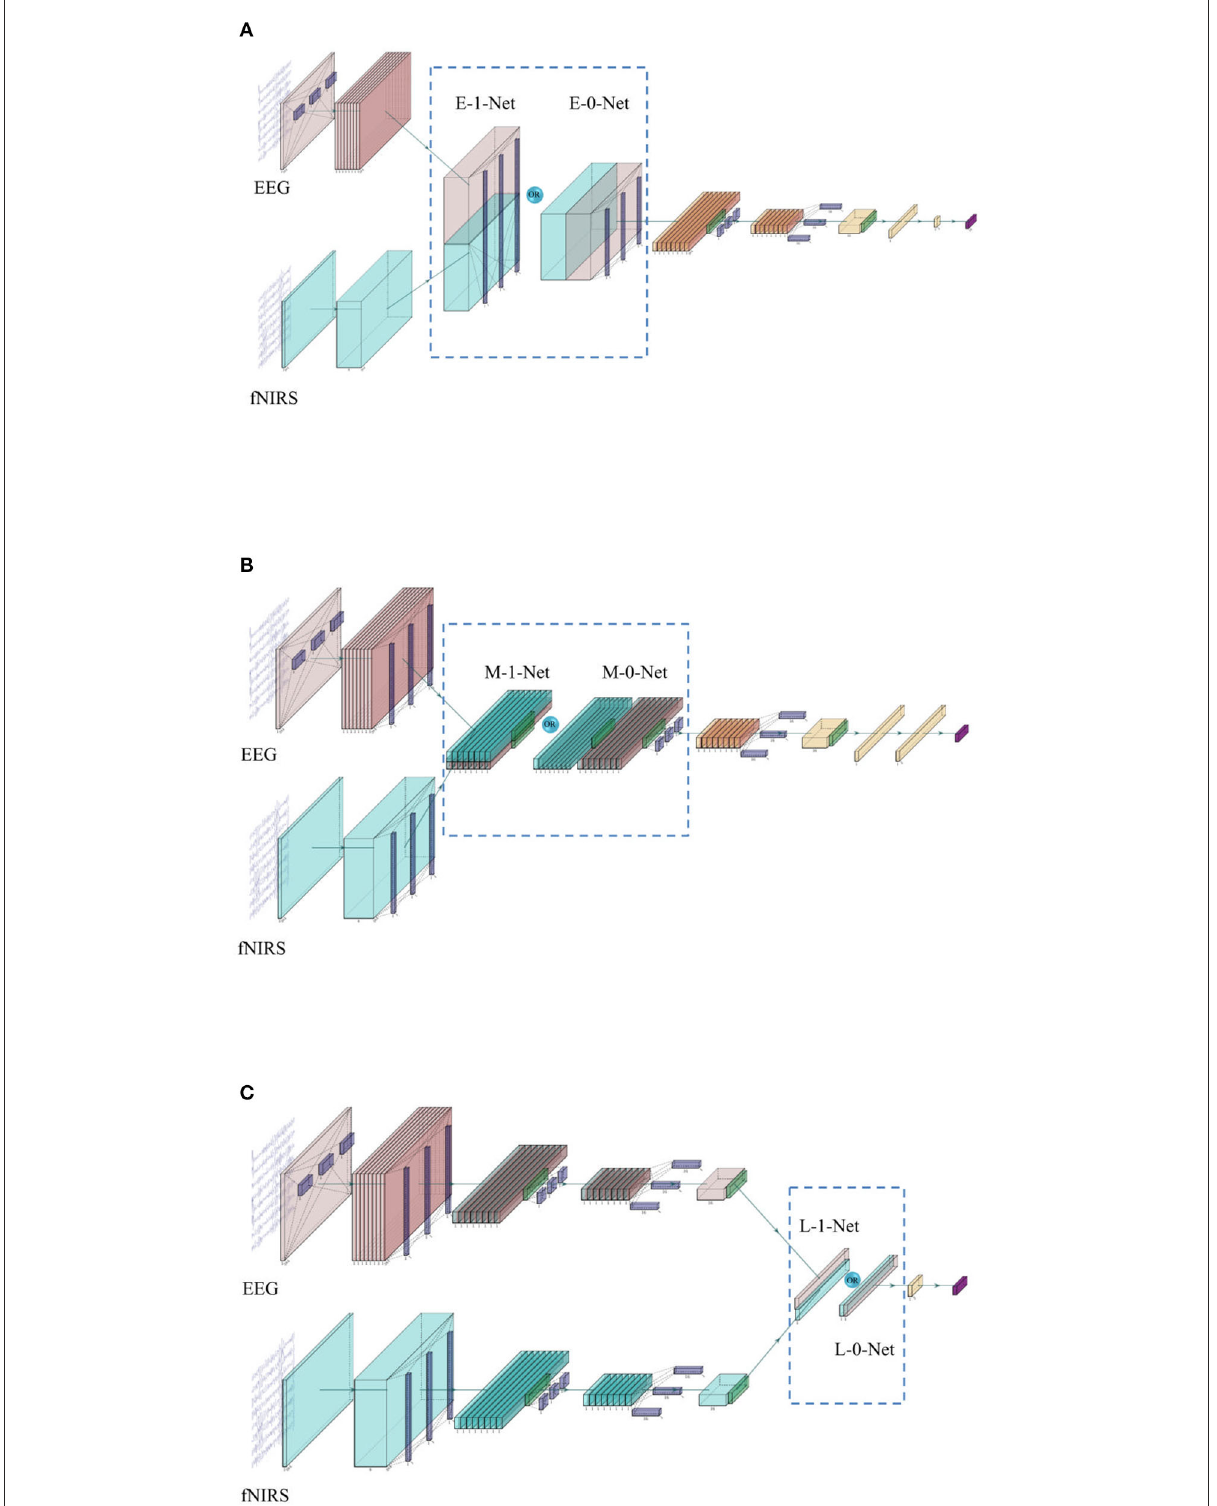
FIGURE2 (A) The network architecture of early stage fusion, which is referred to as E-0-Net and E-1-Net in the following contents, depends on whether the concatenation was performed on the 1st or 2nd dimension. (B) The network architecture of middle-stage fusion, which is referred to as M-1-Net and M-0-Net in the following contents. (C) The network architecture of late-stage fusion, which is referred to as L-1-Net and L-0-Net in the following